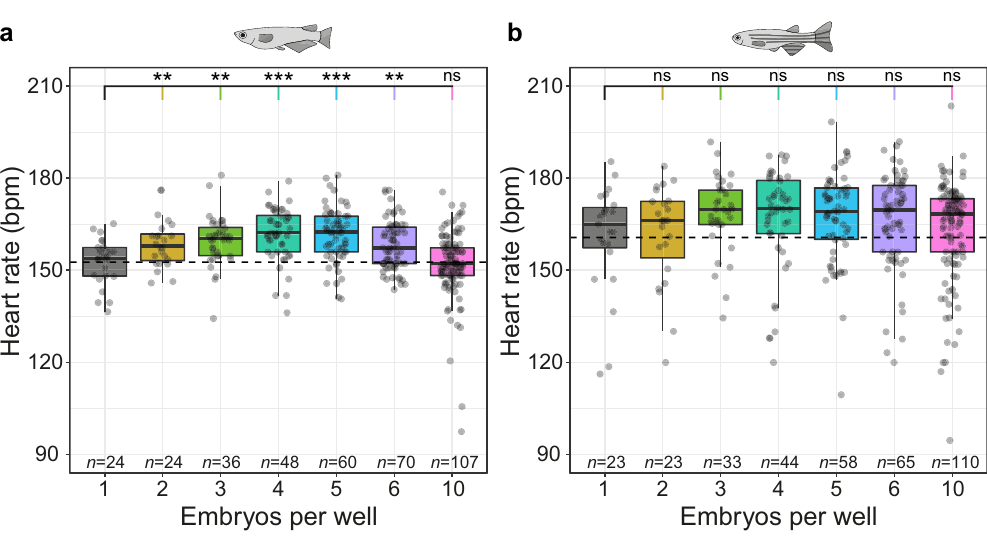
Figure 3. Heartbeat detection of multiple embryos per well. ( a , b ) Scoring of heart rate with 1–6 and 10 embryos per well for medaka at 102 hpf ( a ) and zebrafish at 34 hpf ( b ). Data is provided as box plots and scatter plots of original heart rate measurements. Heart rates of mounting groups with ≥ 2 embryos per well were each tested with Student’s t- test against 1 embryo per well (dashed line indicates mean heart rate of the group with 1 embryo per well); significant differences are indicated with * P < 0.05, ** P < 0.01 and *** P < 0.001, ns (not significant); n for each group is indicated in the